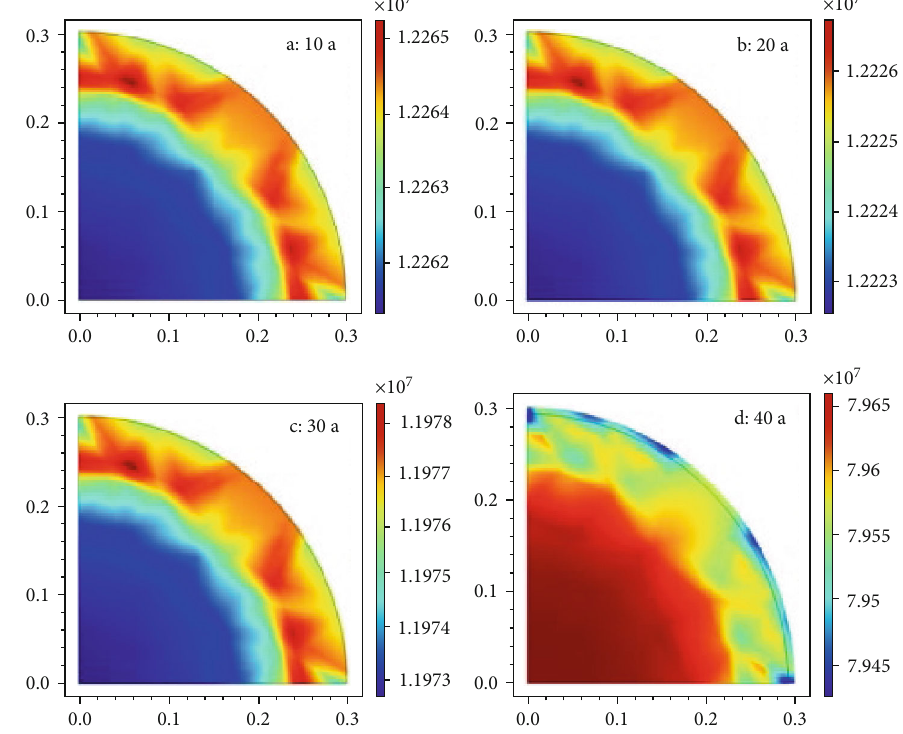
Figure 10: The von Mises stress distribution characteristics of middle section of circular pile under di ff erent